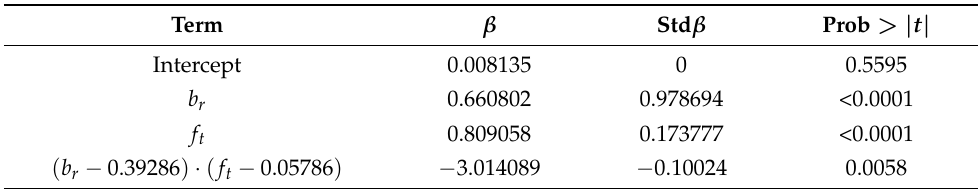
Table 3. Equation coefficients for raw data β and standardized data Std β as well as the results of the t test for the coefficients of the regression equation for the Sa parameter.